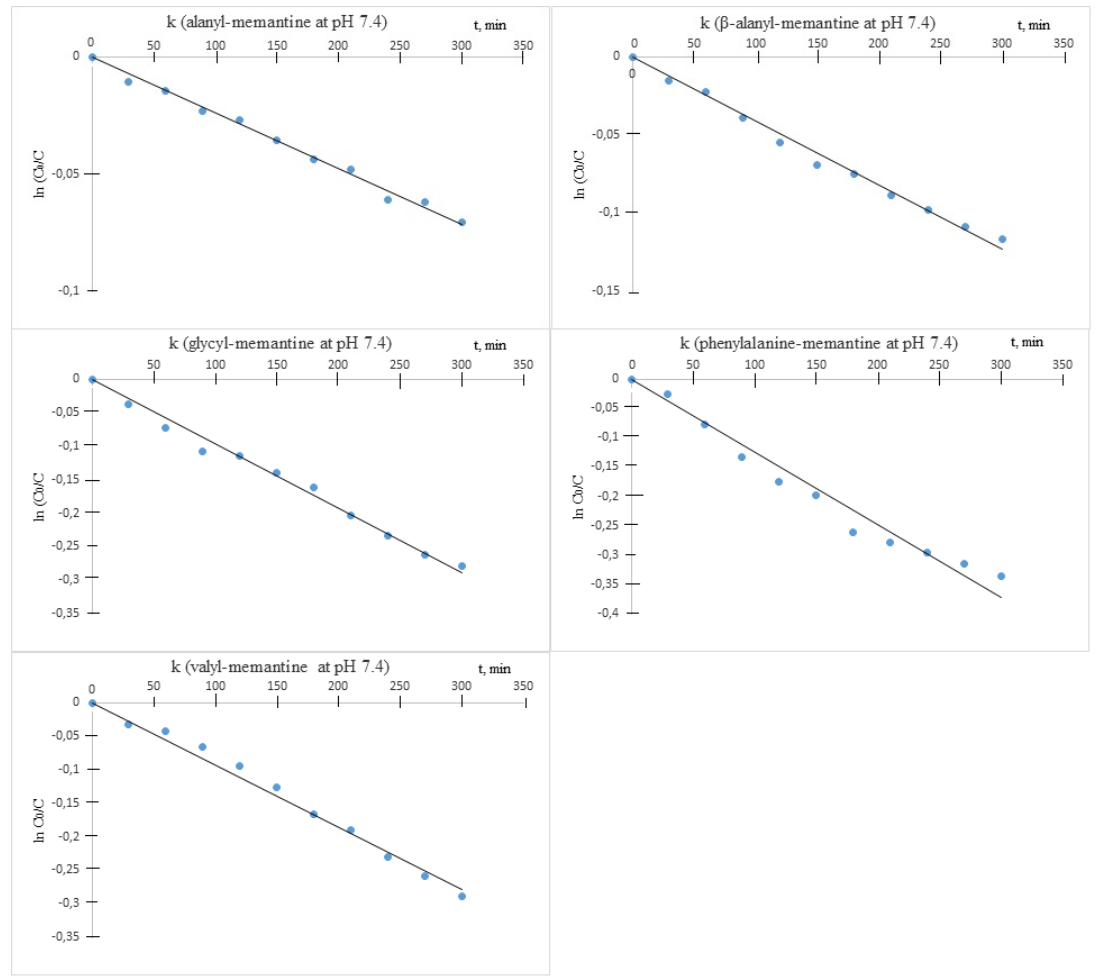
Figure 5. Changing of concentration of the examined memantine derivatives with time at pH 7.4.